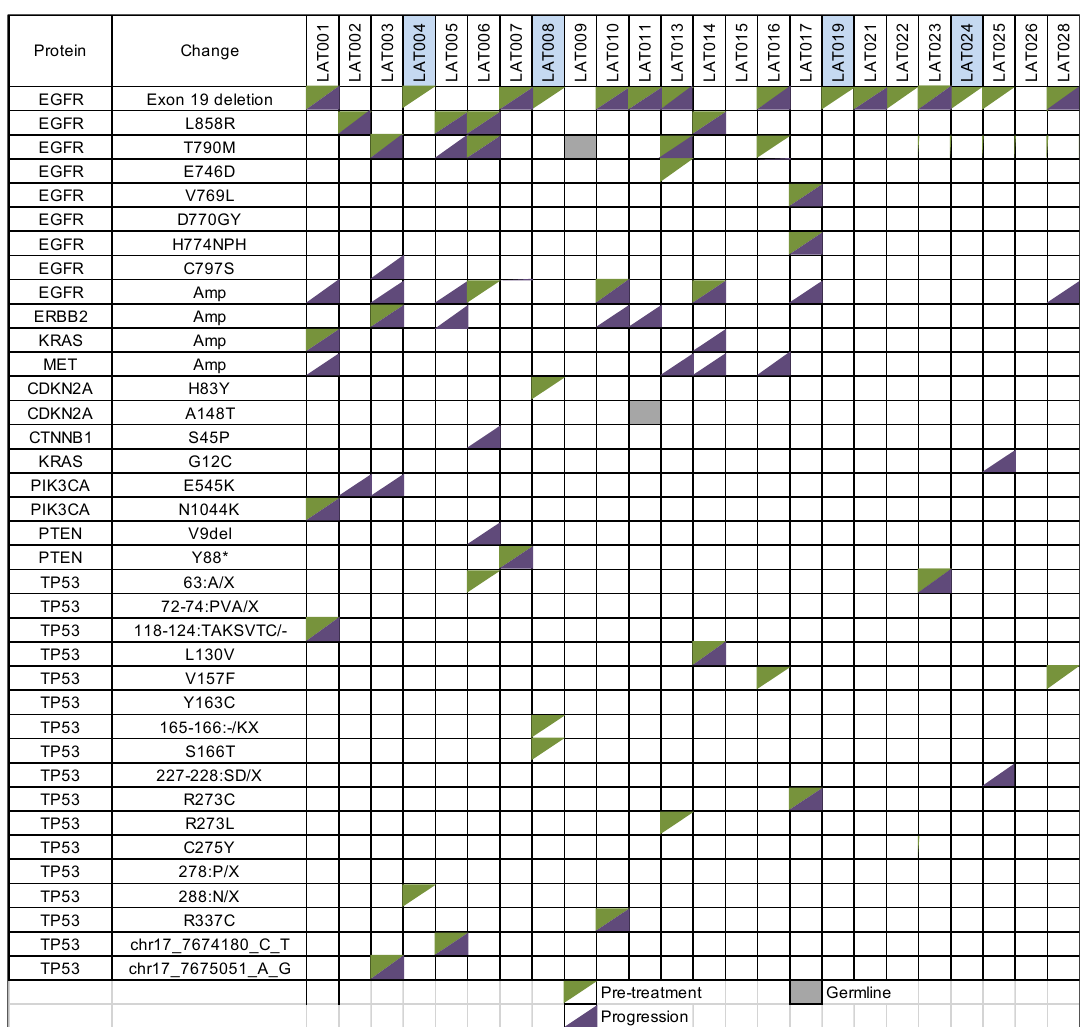
Figure 6. Detection of co-occurring genomic alterations and resistance mechanisms by NGS. Each row represents genomic alterations and columns indicate each patient. Co-occurring mutations at baseline prior to exposure to osimertinib are color-coded in green and genomic alterations seen at progression are in dark purple. Germline mutations are shown in gray. Patients whose disease did not progress at the time of analysis are color-coded in blue (LAT004, LAT008, LAT019, LAT024).